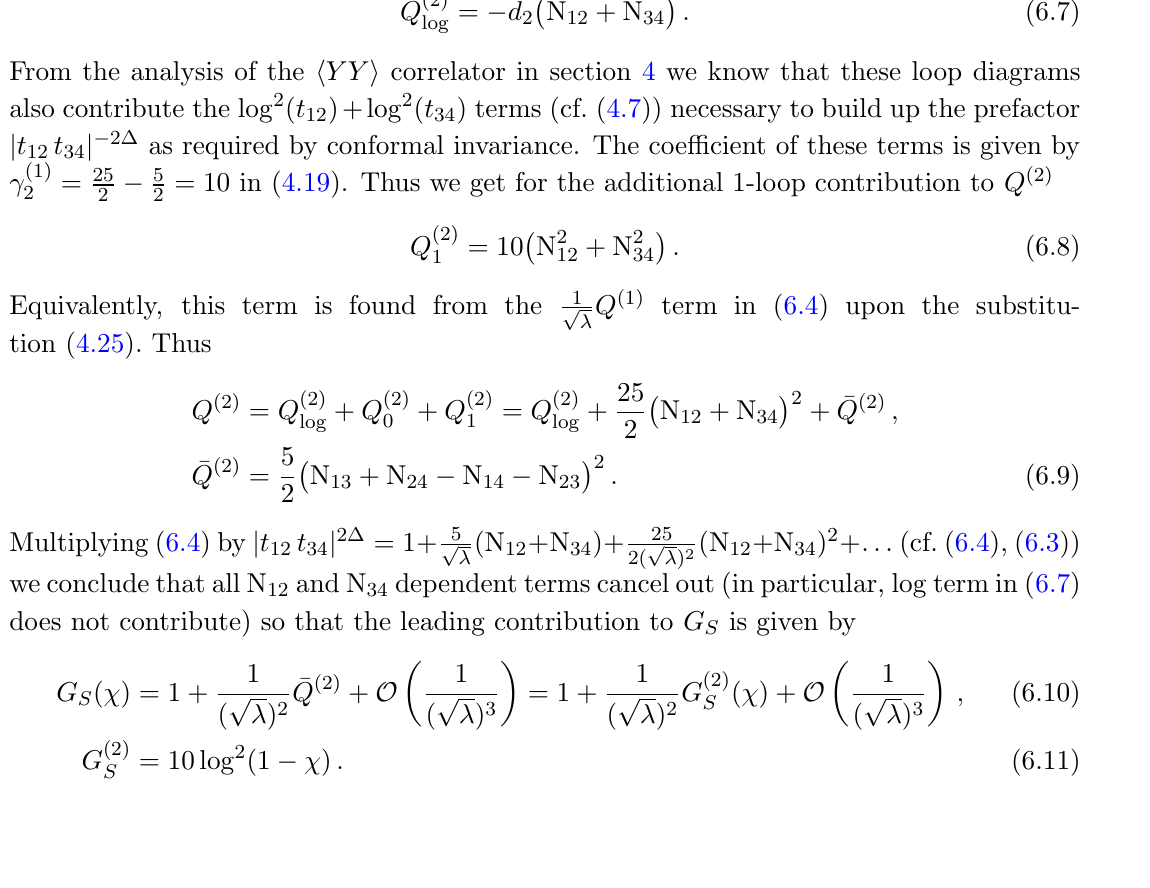
Figure 9 . A disconnected diagram contributing h Y A Y A Y B Y B i . The (cid:16) -propagator includes loop corrections, with 1-loop ones corresponding to the second and third diagram in (cid:12)gure